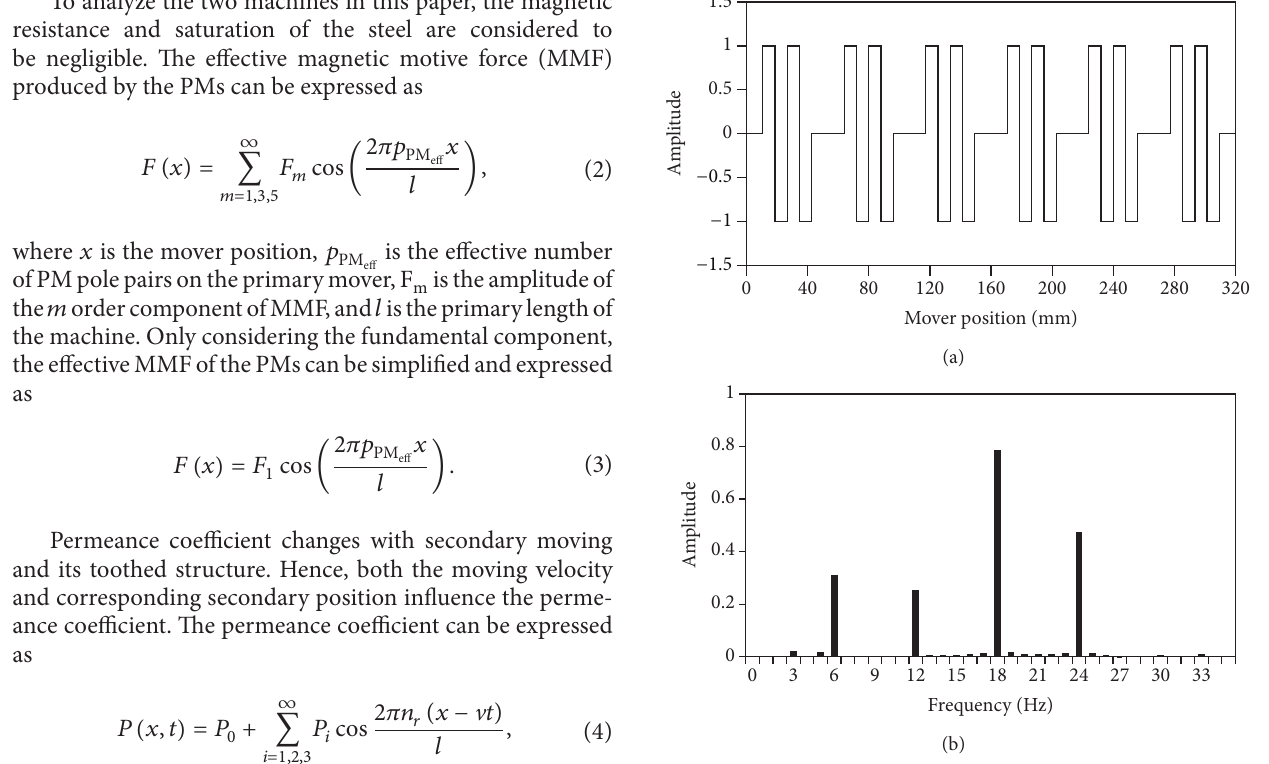
Figure 3: PM MMF waveform and spectra. (a) PM MMF waveform. (b)